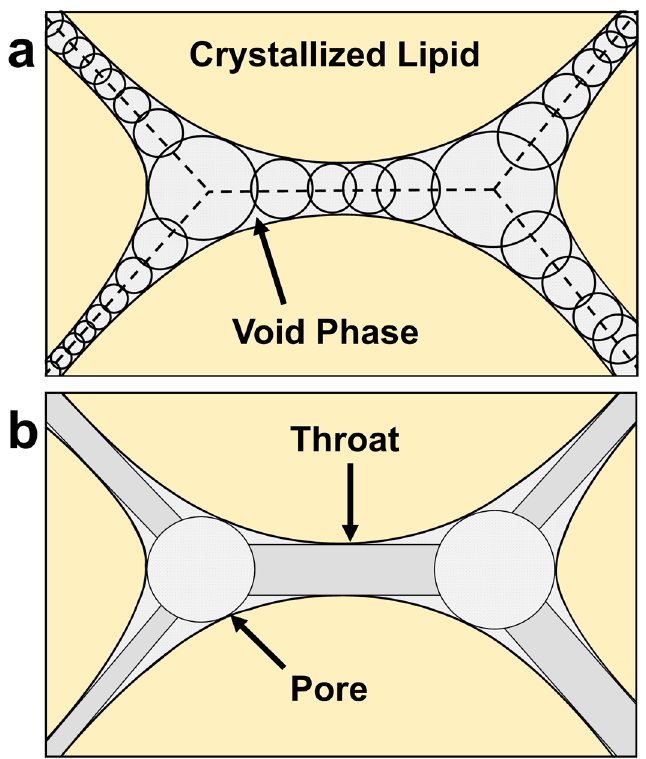
Figure 8. A depiction of how the MB algorithm discretizes the void phase of lipids from ( a ) maxi- mally inscribed spheres along the medial axis (dashed lines) into ( b ) pores and throats. inscribed spheres along the medial axis (dashed lines) into ( b ) pores and